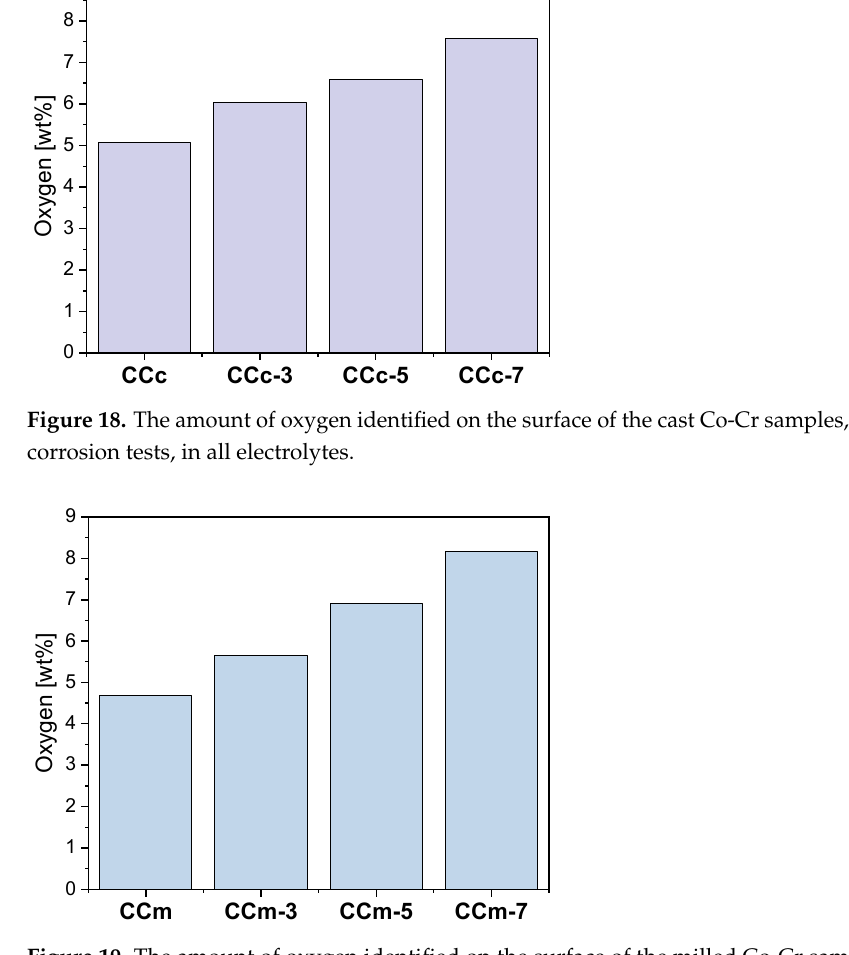
after corrosion tests, in all electrolytes.